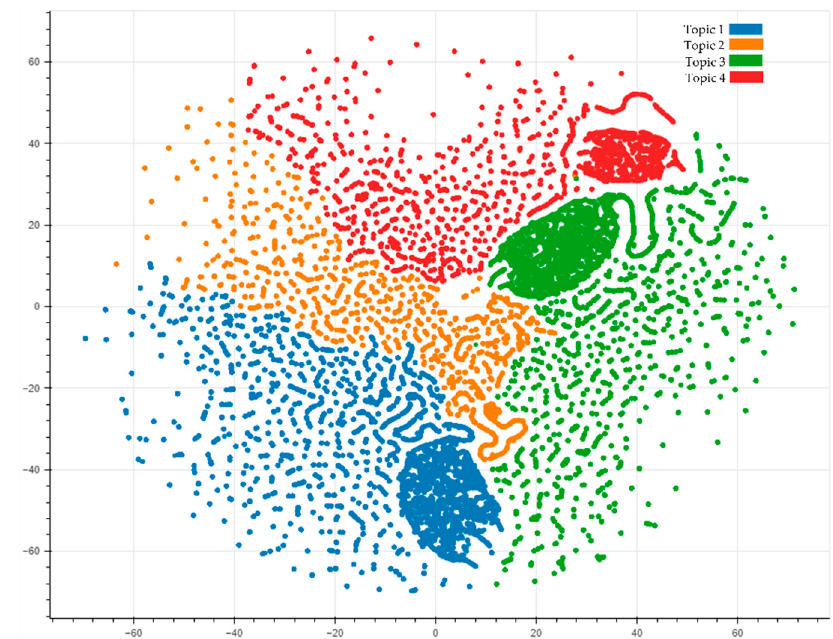
Figure 7. Visualization of the topic modeling analysis for Facebook posts.